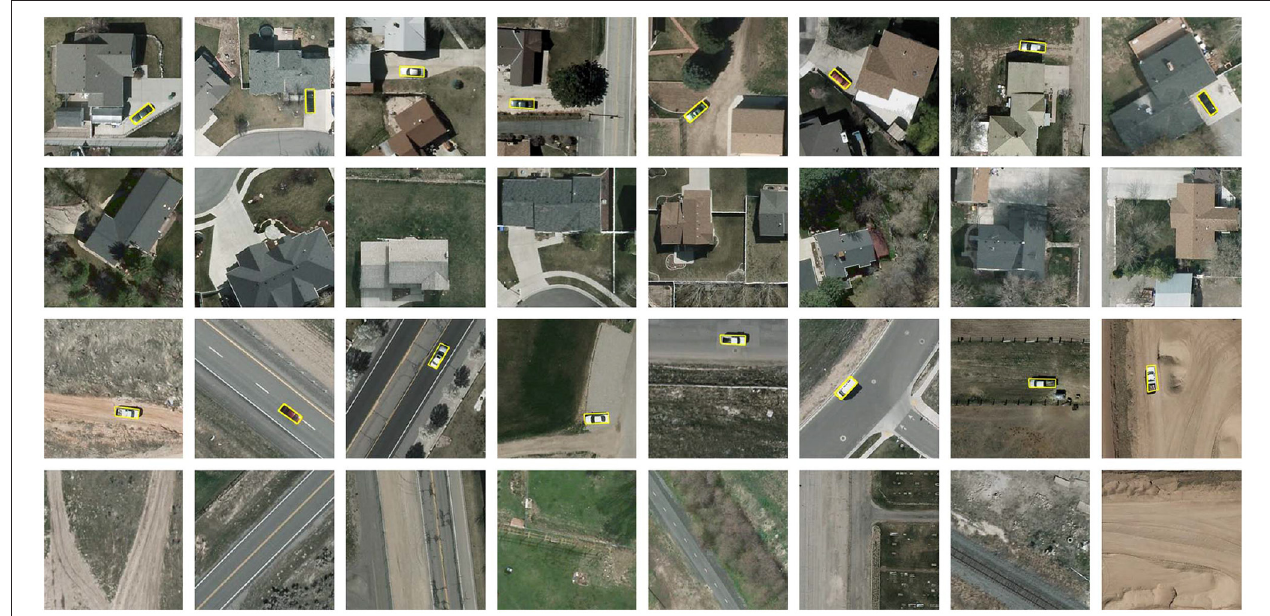
FIGURE 2 | Stimuli for vehicle detection. From top to bottom each row: complex-scene target, complex-scene non-target, simple-scene target and simple-scene non-target. Vehicles are marked with yellow boxes.